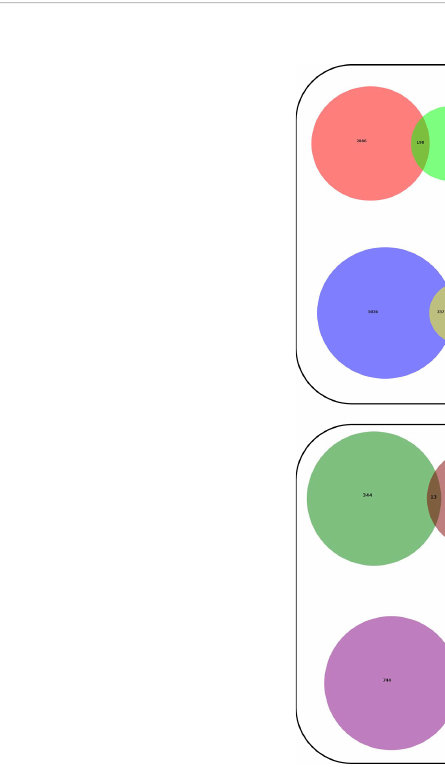
FIGURE 2 Construction of Venn diagrams for key DEGs identi fi cation in AR and NAR group. First method for identifying 28 co-expressed genes. The intersection of GSE112927 and GSE120396 yielded the fi rst group of 198 co-expressed genes. The 357 co-expressed genes at the intersection of our center and GSE120649, 758 co-expressed genes at the intersection of our center and GSE131179, and 257 co-expressed genes at the intersection of our center and GSE145503 were obtained. The following three groups of genes were then intersected with the fi rst group of 198 co-expressed genes. Three groups of co-expressed genes were merged to obtain 28 co-expressed genes (FH, TKT, SMARCD1, CLIC3, XRCC6, KHSRP, PPP1R3B, TOE1, ZFAND6, ITGAL, KIF3B, EIF4G1, FGFRL1, PRPF19, CD58, NABP1, PPM1G, TBCD, CCDC92, MDH2, PDIA4, SMARCAL1, GOT2, DNAJC11, MED24, BCL6, IFRD1, and